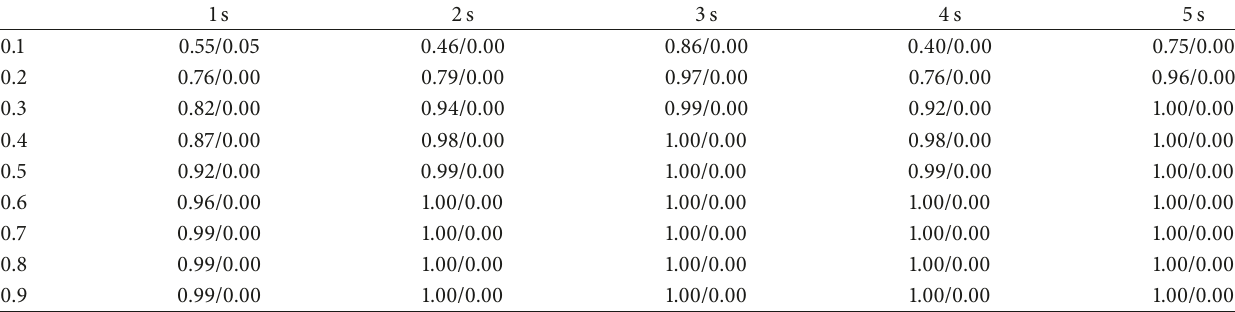
Table 3: FN and FP for the cosine similarity.